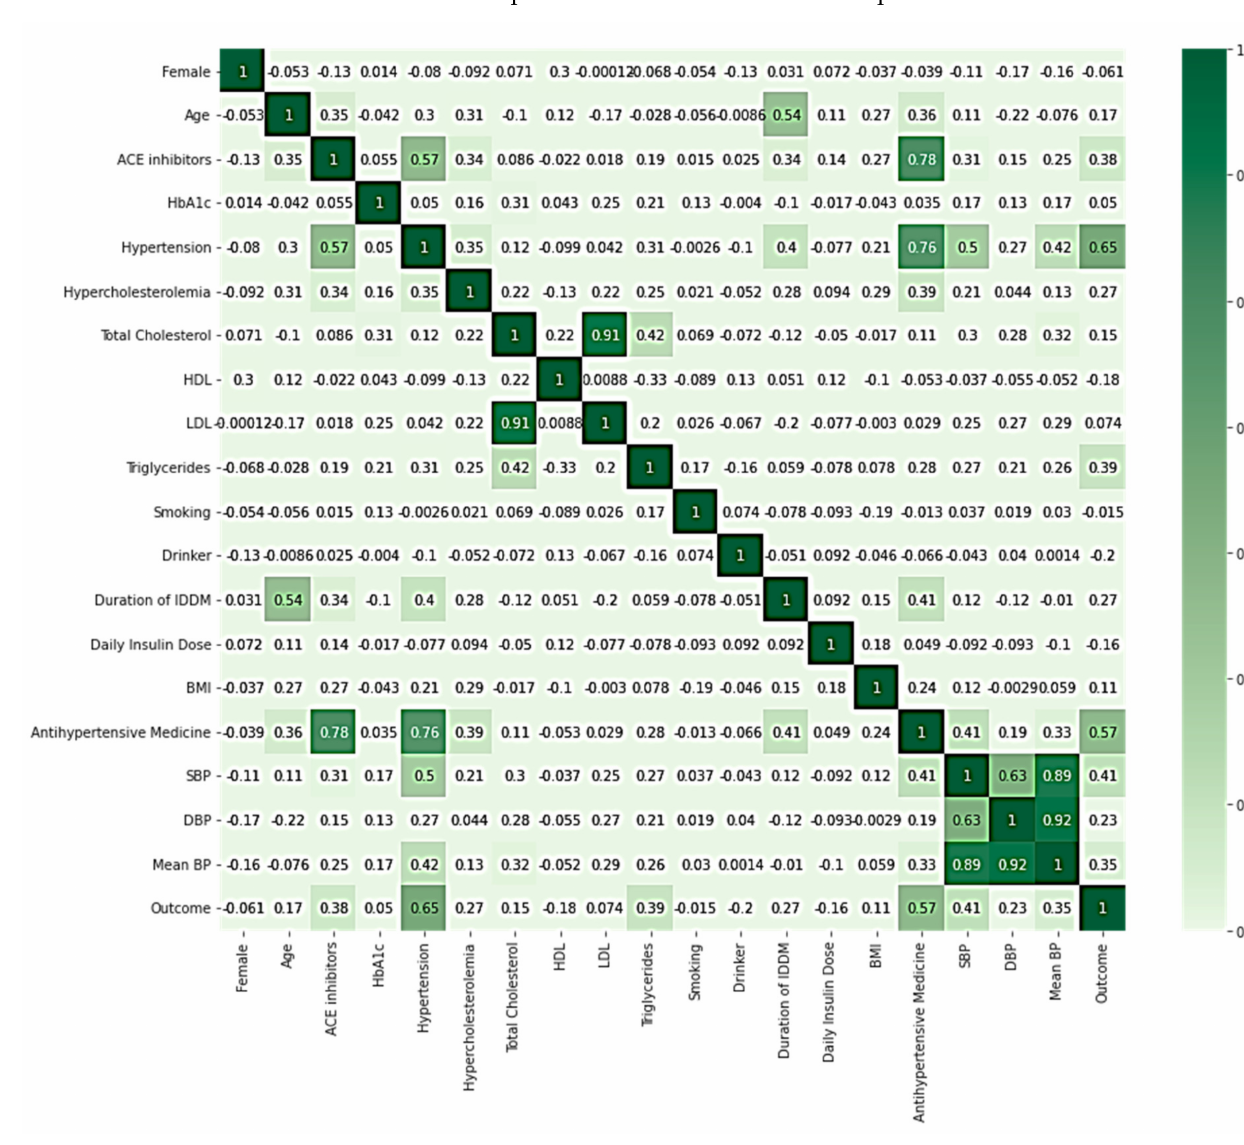
Figure 2. Features correlation heatmap of Dataset